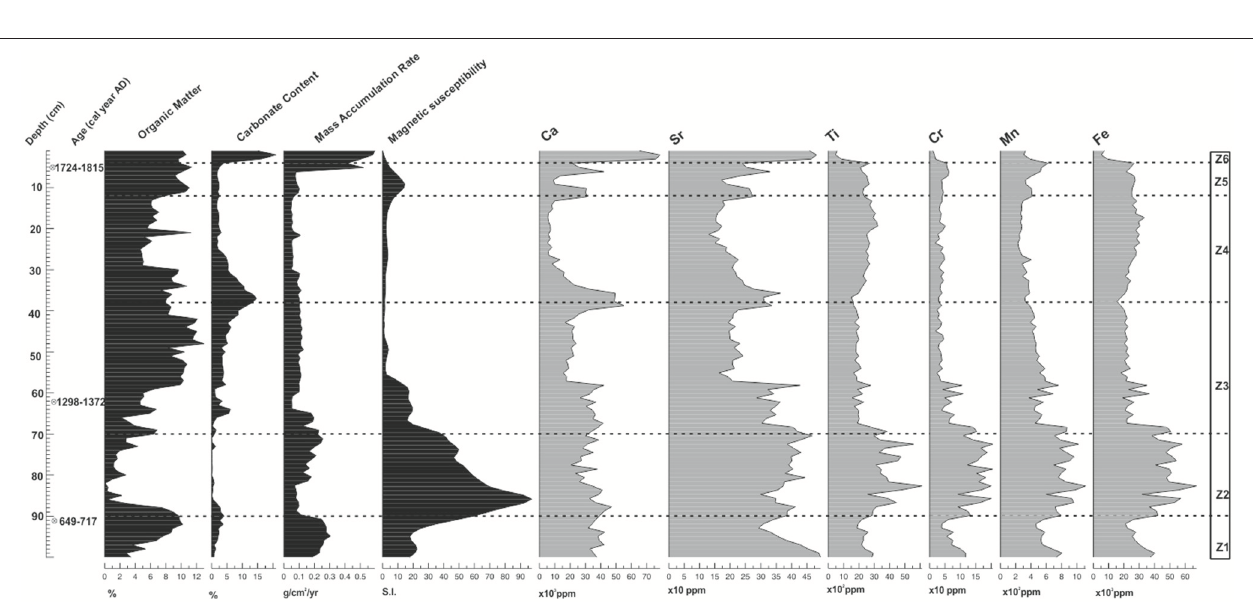
FIGURE 3 | Pollen percentage diagram, pollen concentration, palynological richness and microscopic charcoal concentration for mangrove forest of the Cuyutlan Lagoon in the Pacific coast of Mexico. Divisions are delineated by zones according to the optimal splitting option available in PSIMPOLL 4.27( Bennett, 2009). Dates on the Y-axis are calibrated yr AD.